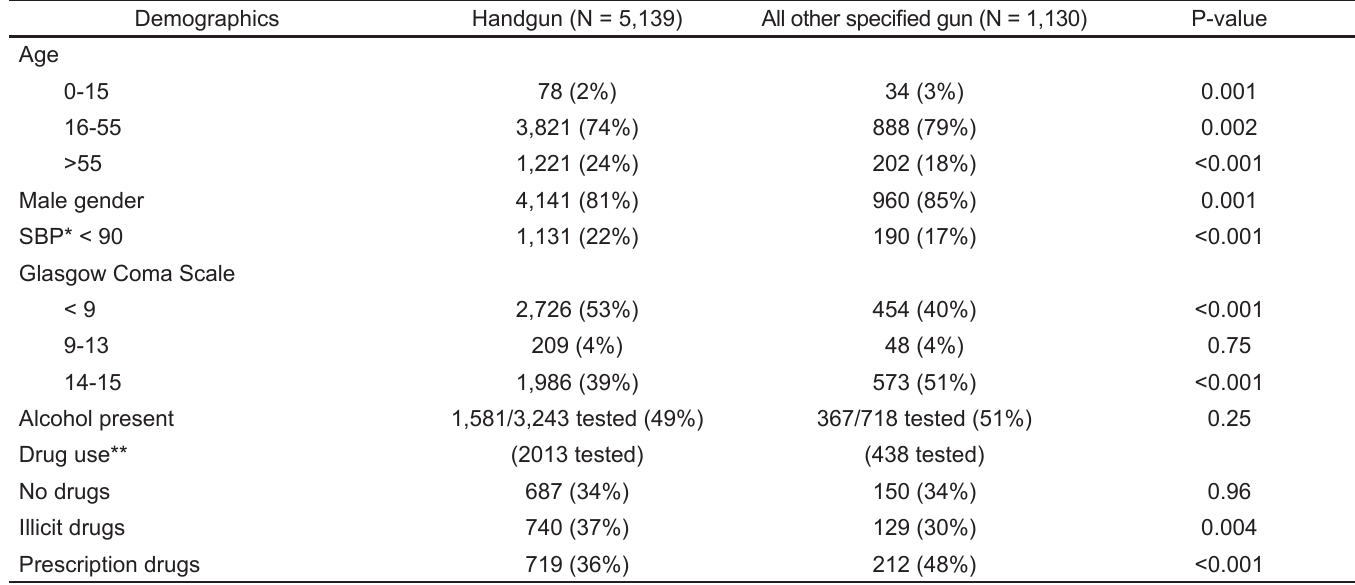
Table 1. Comparison of the handgun group vs all other specified gun group